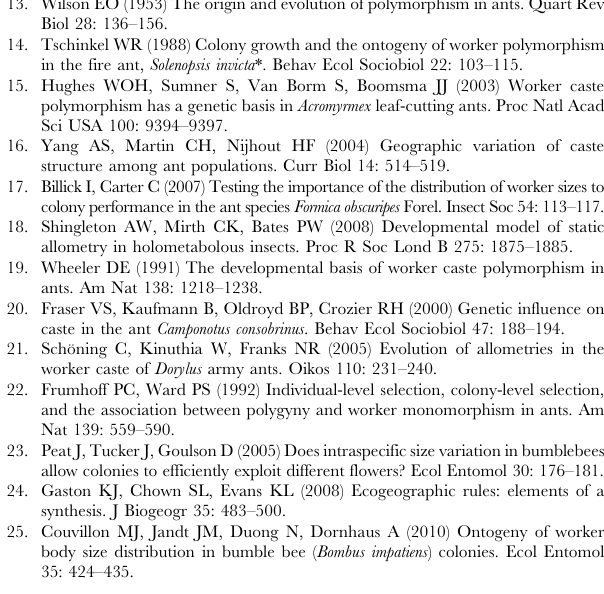
Figure S1 Body mass (mg) frequency distributions of males and females separately for 12 of the insect species considered. The distributions for the females are presented on the left and the male distributions are on the right. The distributions are as follows; ( a ) Gryllus bimaculatus females and ( b ) males, ( c ) Dira clytus females and ( d ) males, ( e ) the ant species females and ( f ) males, ( g ) Rhagovelia imaculata females and ( h ) males, ( i ) Setapion provinciale females and ( j ) males, ( k ) the chrysomelid species females and ( l ) males, ( m ) Ceratitis capitata females and ( n ) males, ( o ) Henosepilachna vigintioctopunctata females and ( p ) males, ( q ) Trichilogaster acaciaelongifoliae females and ( r ) males, ( s ) Trichilogaster signiventris females and ( t ) males, ( u ) Pachnoda sinuata females and ( v ) males, and ( w ) Gonipterus scutelatus females and ( x ) males. Figure S2 Body length (mm) frequency distributions of males and females separately for 12 of the insect species considered. The distributions for the females are presented on the left and the male distributions are on the right. The distributions are as follows; ( a ) Gryllus bimaculatus females and ( b ) males, ( c ) Dira clytus females and ( d ) males, ( e ) the ant species females and ( f ) males, ( g ) Rhagovelia imaculata females and ( h ) males, ( i ) Setapion provinciale females and ( j ) males, ( k ) the chrysomelid species females and ( l ) males, ( m ) Ceratitis capitata females and ( n ) males, ( o ) Henosepilachna vigintioctopunctata females and ( p ) males, ( q ) Trichilogaster acaciaelongifoliae females and ( r ) males, ( s ) Trichilogaster signiventris females and ( t ) males, ( u ) Pachnoda sinuata females and ( v ) males, and ( w ) Gonipterus scutelatus females and ( x ) males.